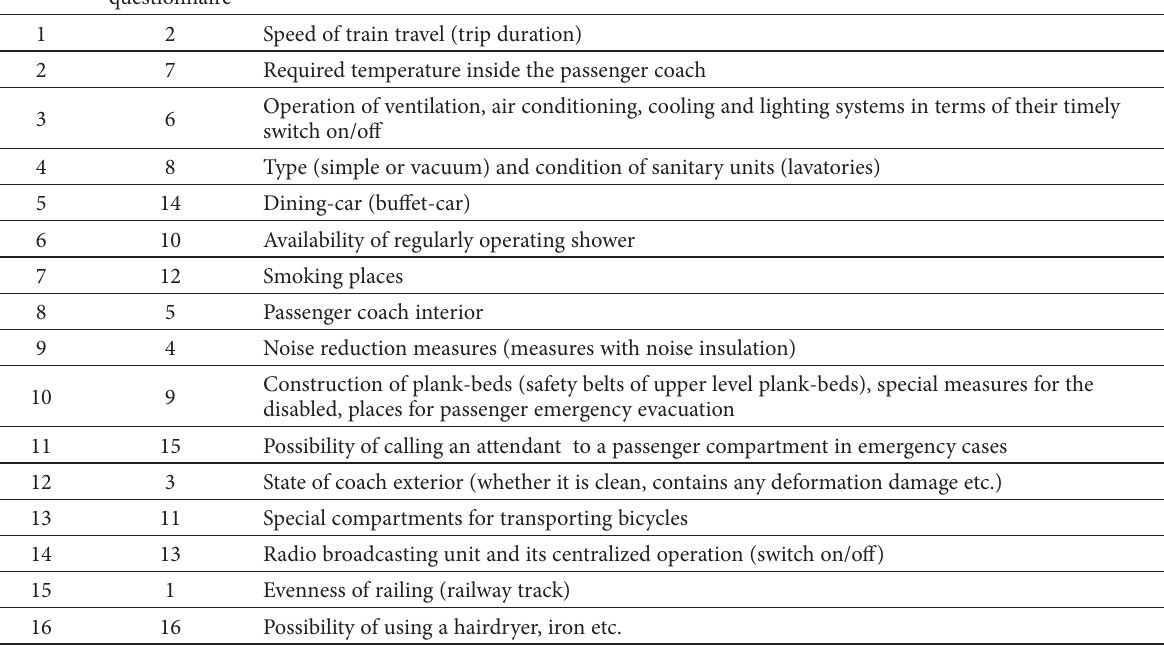
Fig. 3. Th e bar diagram showing the importance of criteria related to train elements and the technical state of the railway